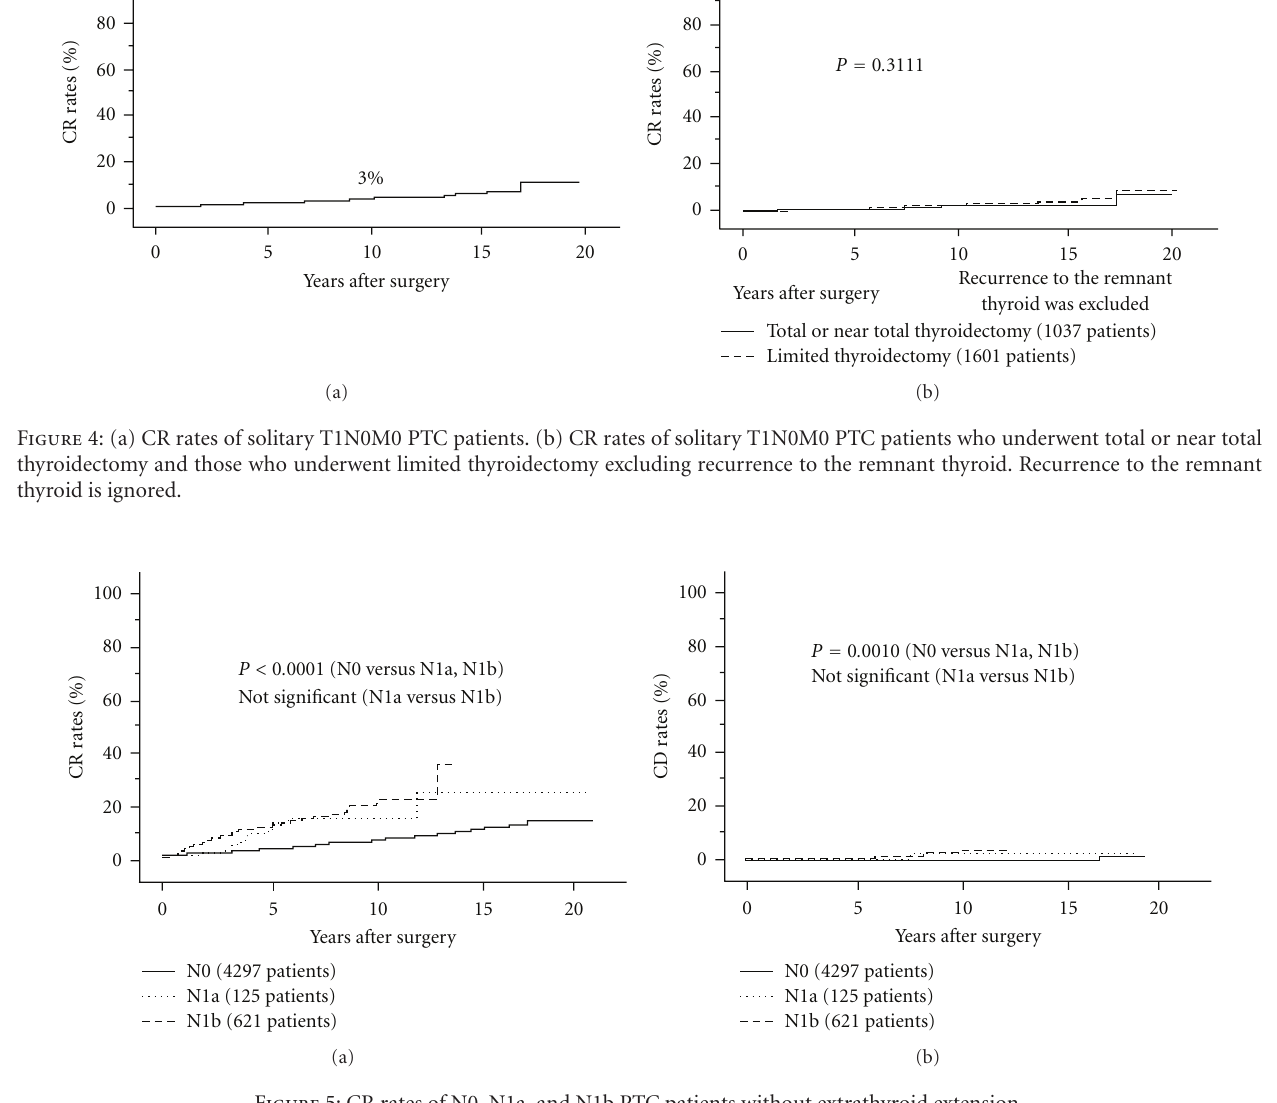
Figure 5: CR rates of N0, N1a, and N1b PTC patients without extrathyroid